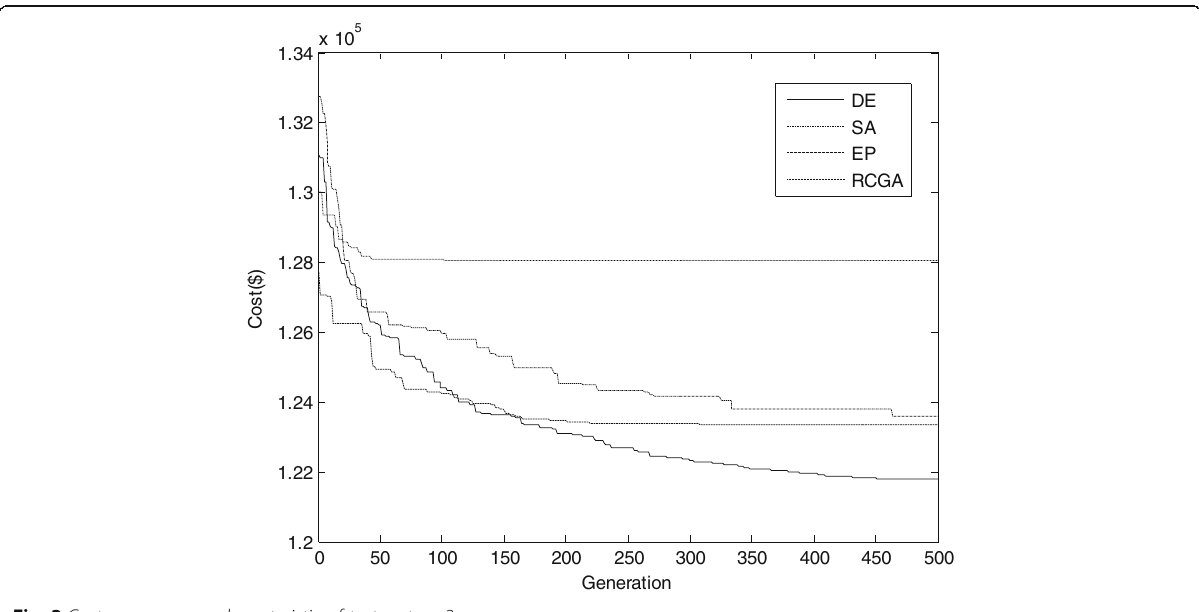
Fig. 3 Cost convergence characteristic of test system